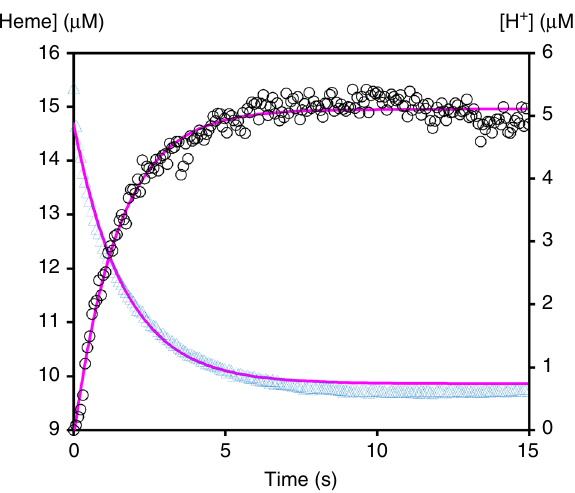
Fig. 4 Electron transfer and proton consumption in Qrc/MK4 proteoliposomes. Ferrous heme concentration (blue triangles) and proton concentration (black circles) after mixture of reduced TpI c 3 and Qrc/MK4 liposomes (with phenol red inside). The magenta lines correspond to single exponential fi ts with the following equations: heme oxidation: (5.03 ± 0.30) × exp ( − 0.60±0.05)× t ) + (9.78 ± 0.40); proton consumption: − (5.22 ± 0.26) × exp ( − 0.68±0.06)× t + (5.11 ±